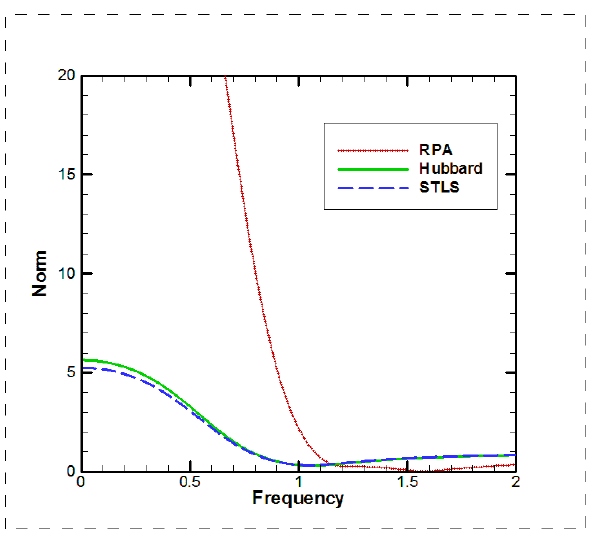
Fig. 7. Norm of dynamic dielectric function of coupled nanolayer within all